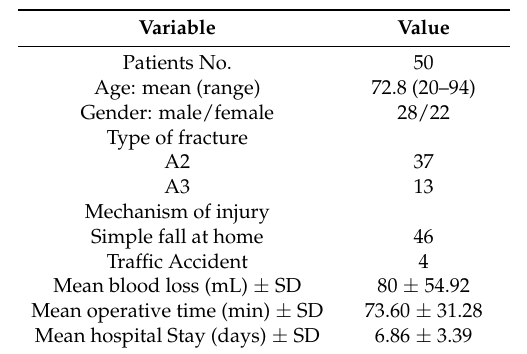
Table 1. The demographic and perioperative characteristics of patients with unstable pertrochanteric fractures who were treated with the PFNA.